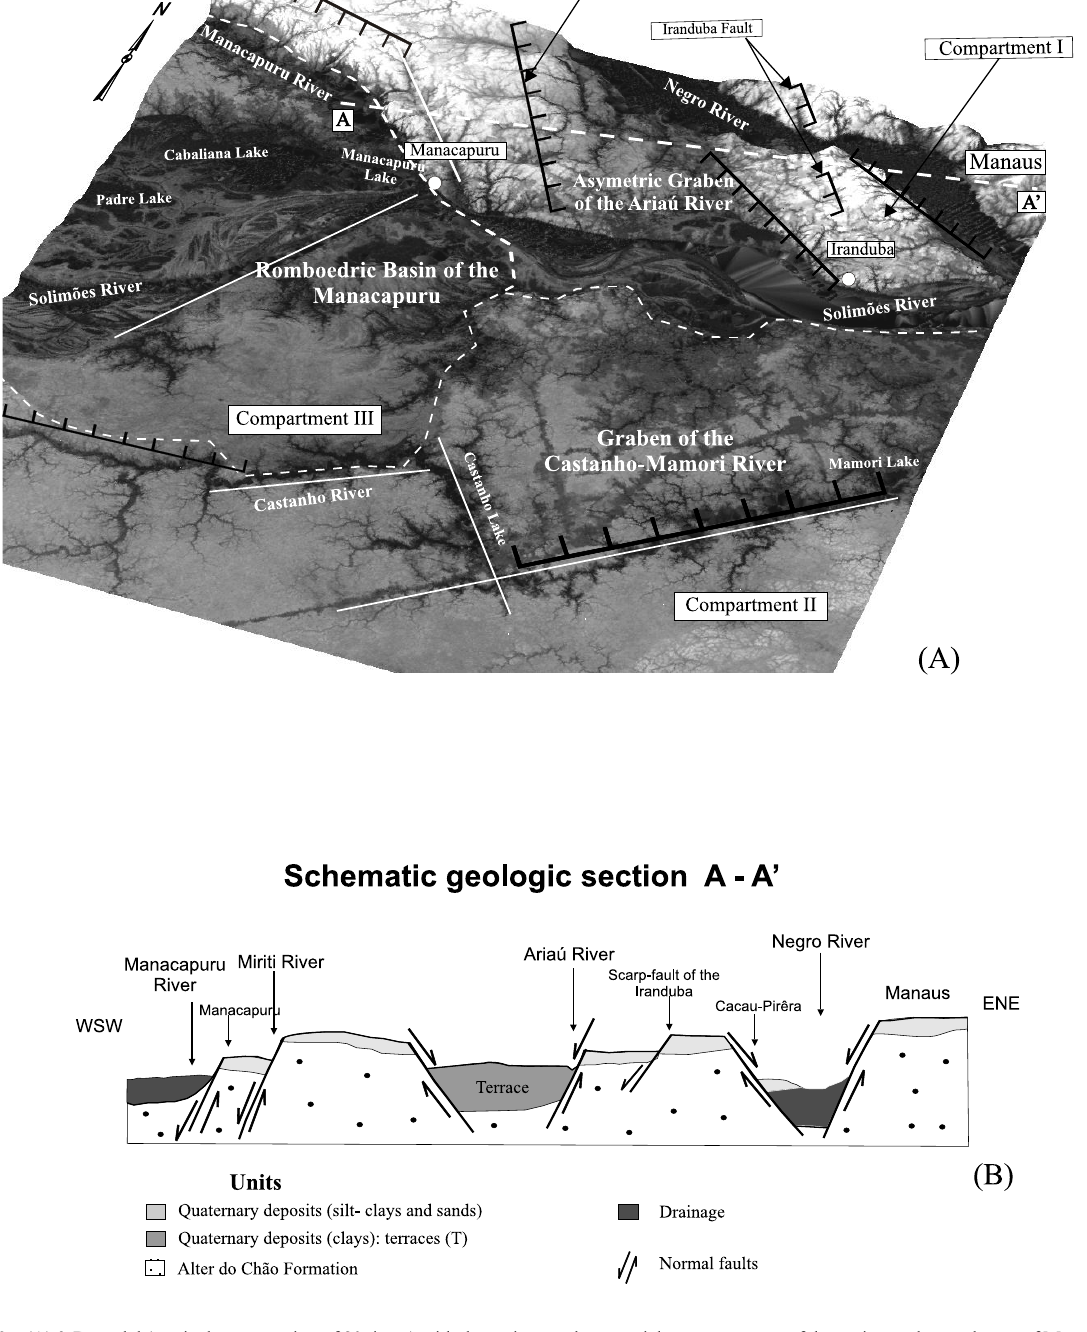
An Acad Bras Cienc (2007) 79